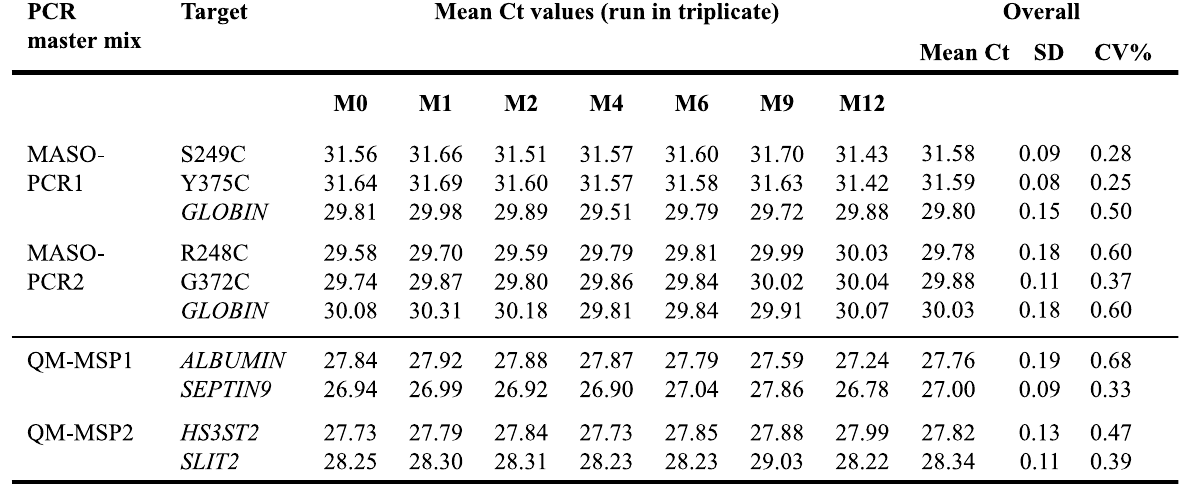
Table 4 High performance of PCR Master mix all-in-one